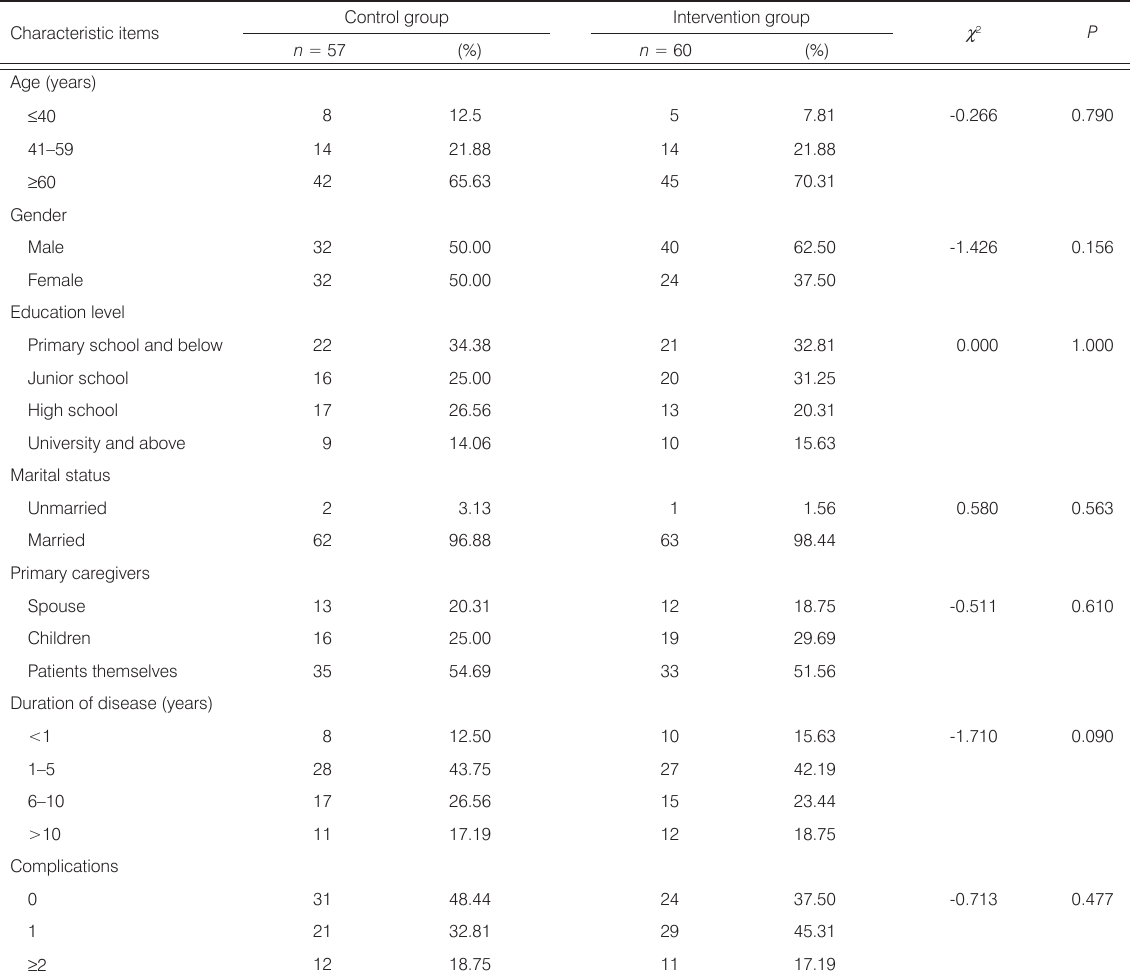
Table 2. Demographic data of the subjects ( n